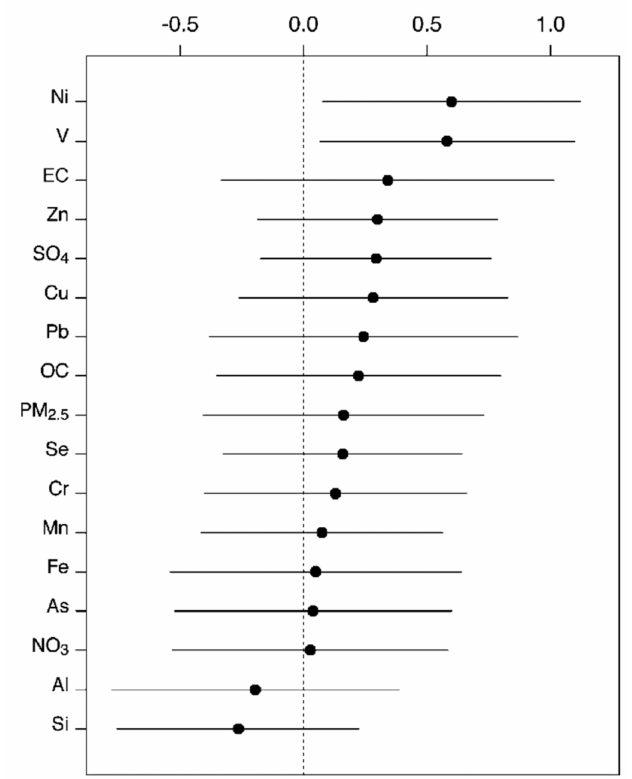
Figure 1. Percent differences in mortality effect estimates per the 5th to 95th percentile changes in PM 2.5 mass and PM 2.5 constituent concentrations across 60 NMMAP metropolitan areas in the US. Reproduced with permission from